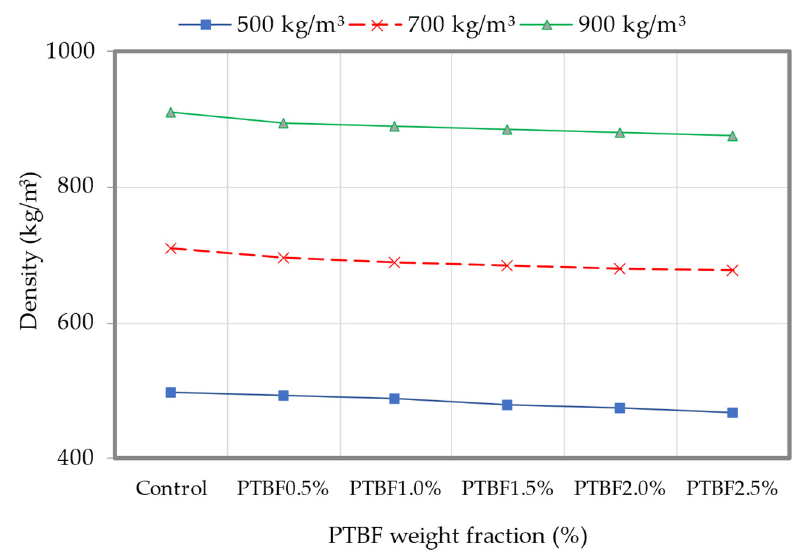
Figure 9. Dry density of LFC with different weight fractions of PTBF.